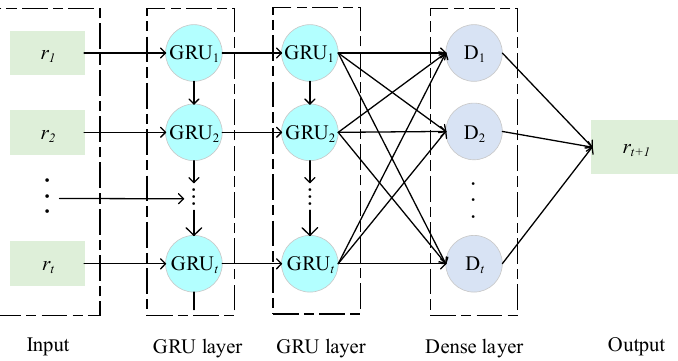
Figure 3. Structure of GRU neural network with nonlinear components.